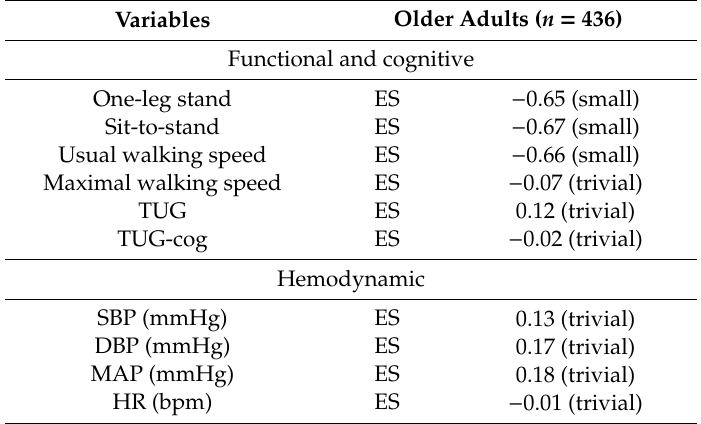
Table 2. ES of functional, cognitive, and hemodynamic parameters.